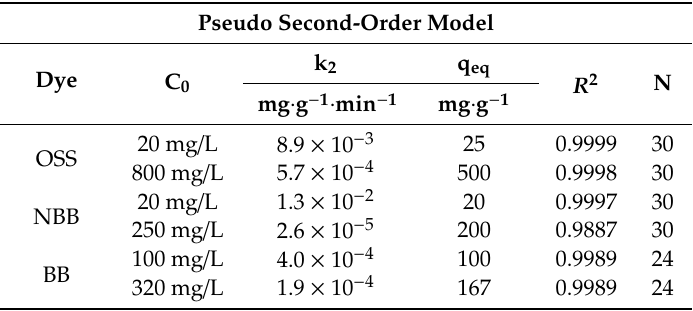
Table 4. Results of pseudo second-order fitting on all kinetic datasets. The number of experimental data used for each dye is reported in column N.